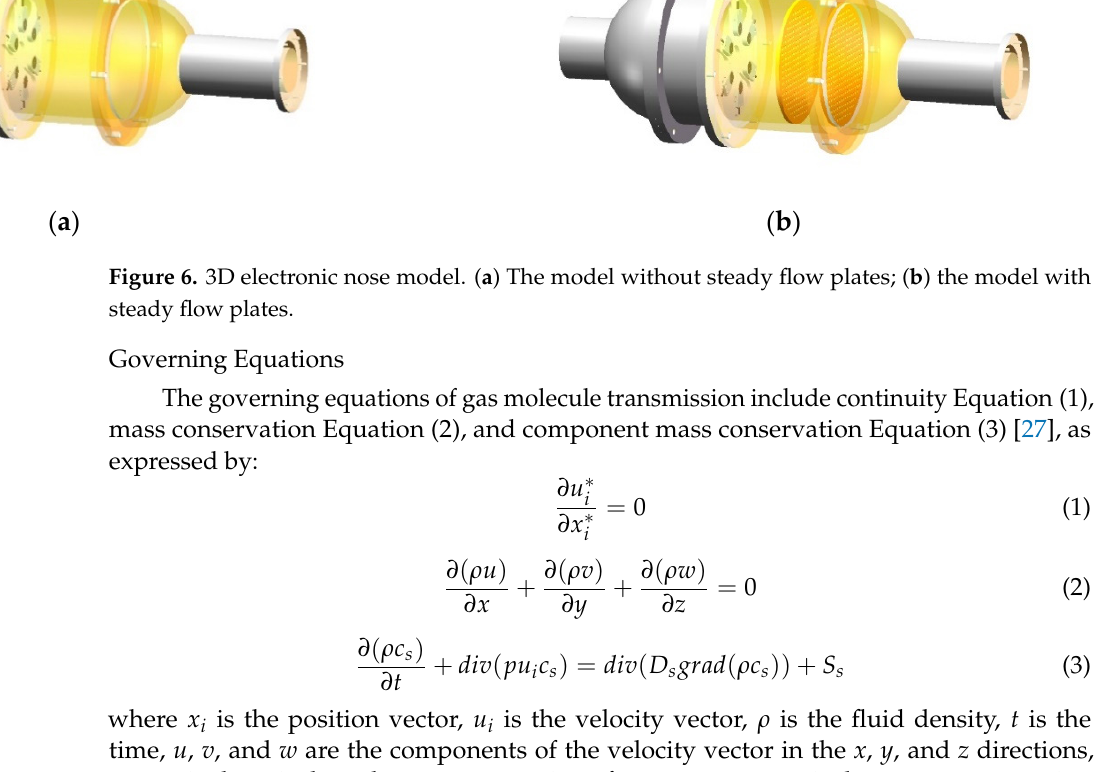
Figure 6. 3D electronic nose model. ( a ) The model without steady flow plates; ( b ) the model with steady flow plates.